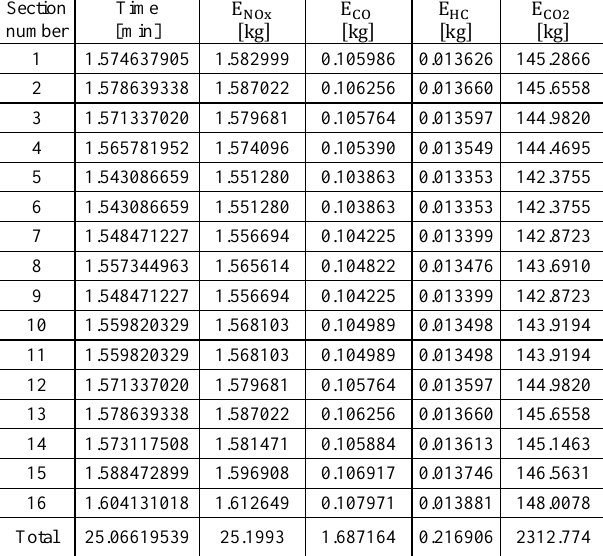
Table 2. Emission of NO x , CO, HC and CO 2 in the exhausts of Gulfstream IV in each section of the flight from Gdansk to Rzeszow with the time given